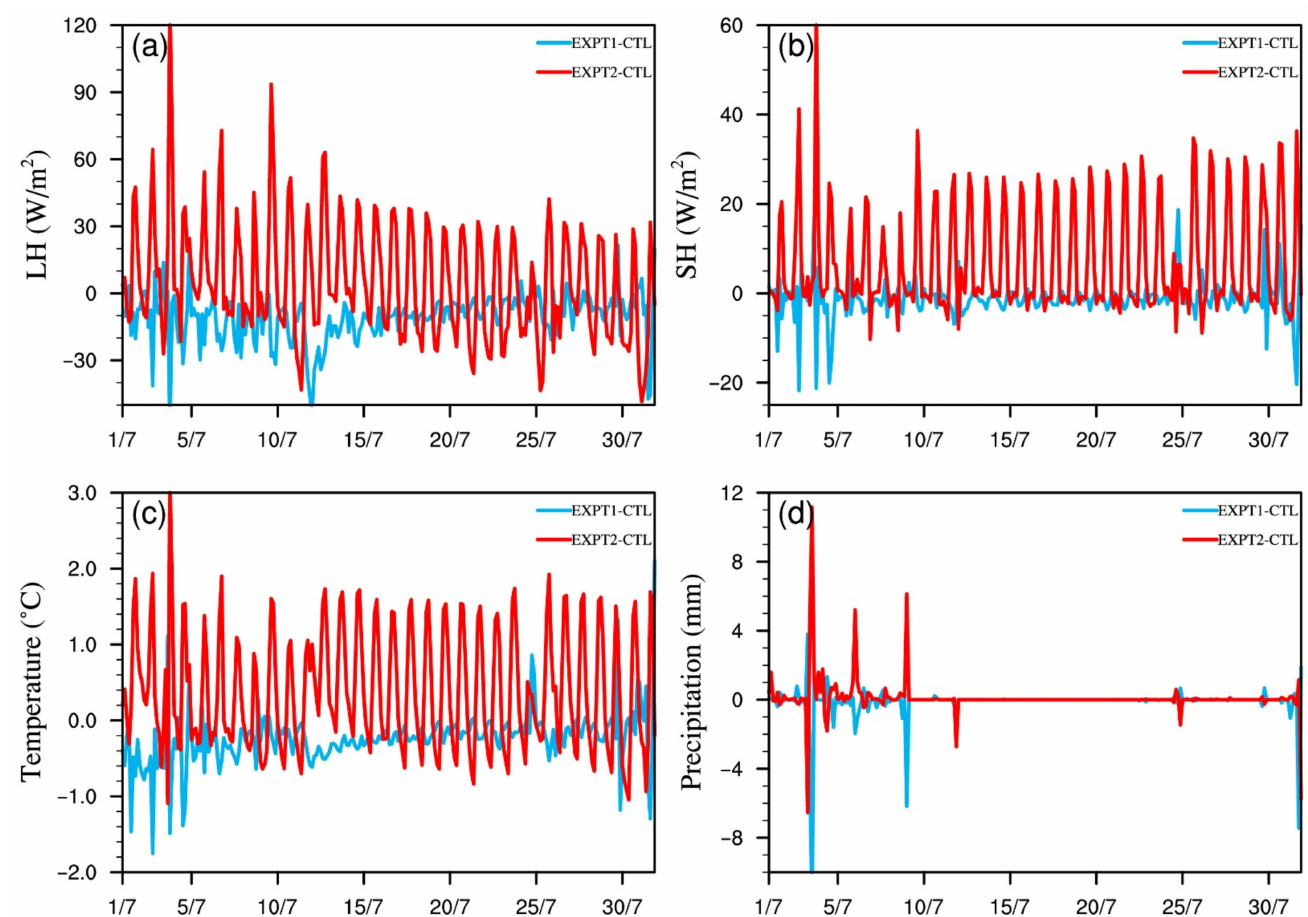
Figure 4. Time series at 3 h intervals of ( a ) latent heat flux (W m − 2 ), ( b ) sensible heat flux (W m − 2 ), ( c ) land surface temperature ( ◦ C), and ( d ) precipitation (mm). The blue lines are the difference between the CTL and EXPT1 (EXPT1–CTL). The red lines are the difference between the CTL and EXPT2 (EXPT2–CTL). The areas used to calculate these four variables have been marked with dashed lines in Figure